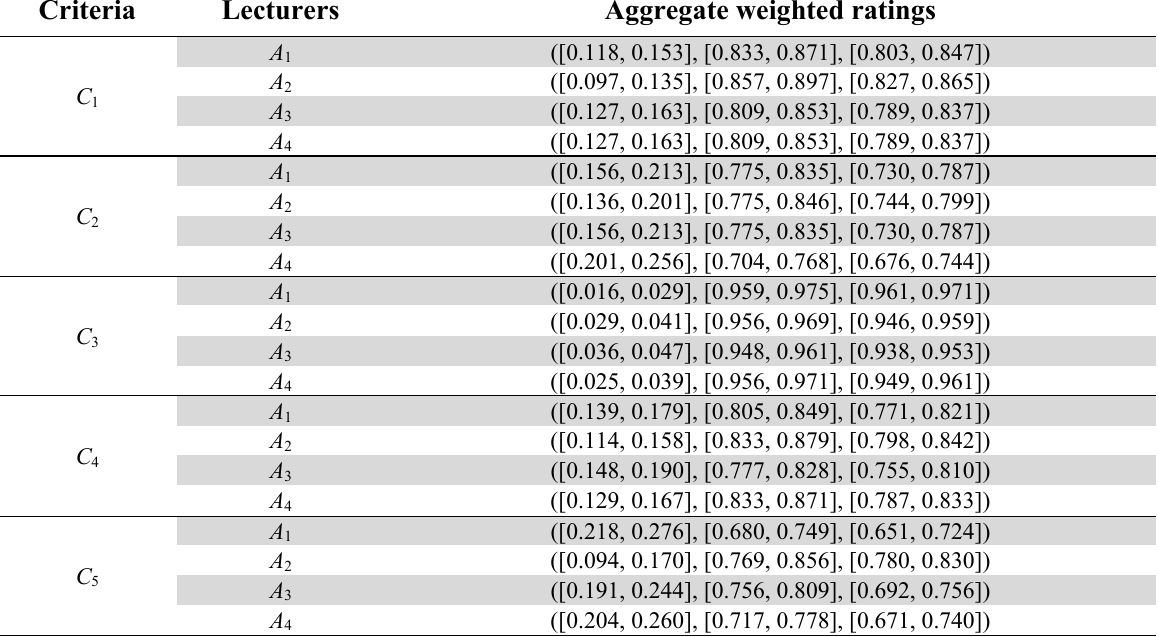
Aggregate weighted rating value of each